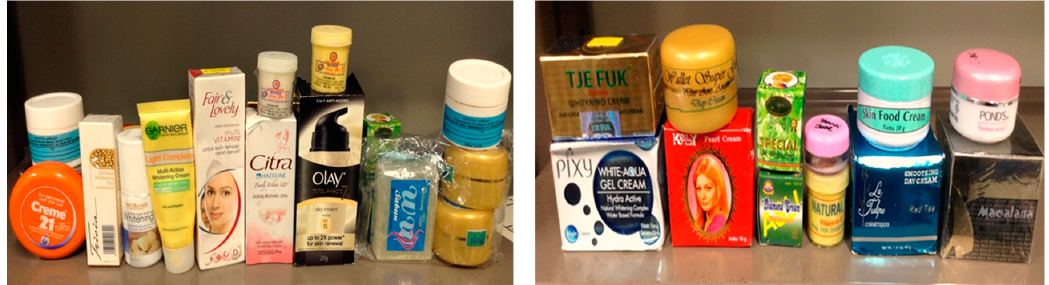
Figure 1. Skin-lightening cosmetic products used by the students.